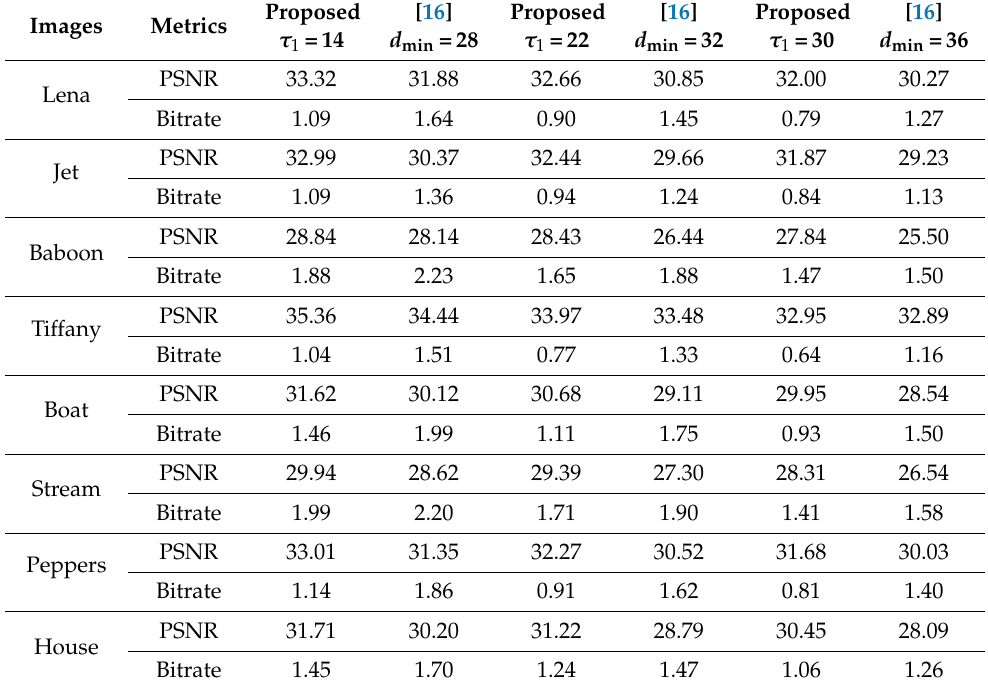
Table 7. Comparisons of PSNR and bitrate with 8 × 8 block